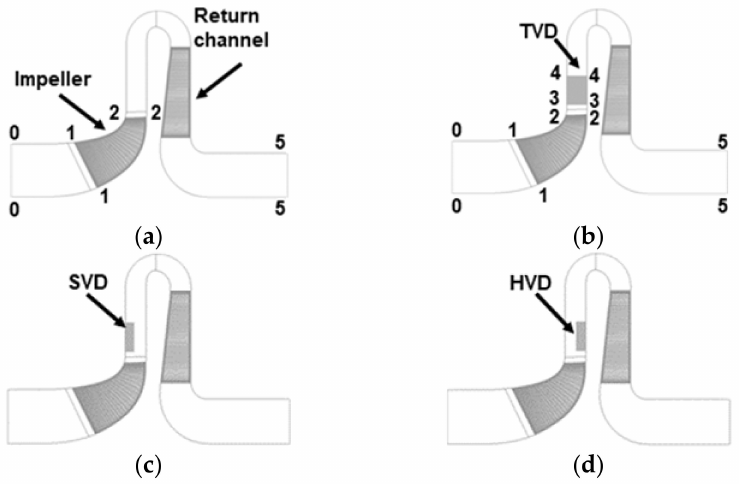
Figure 1. Meridional schematic of diffuser: ( a ) VD; ( b ) FVD; ( c ) SVD; ( d ) HVD.